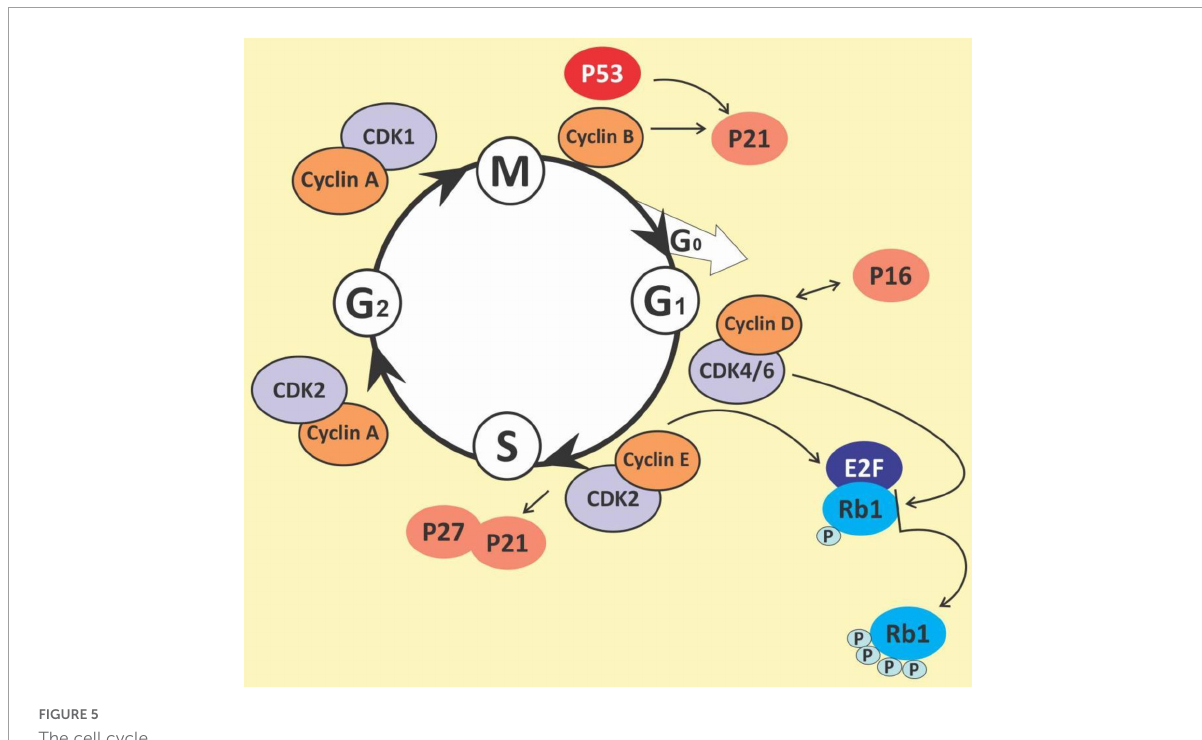
FIGURE5 The cell